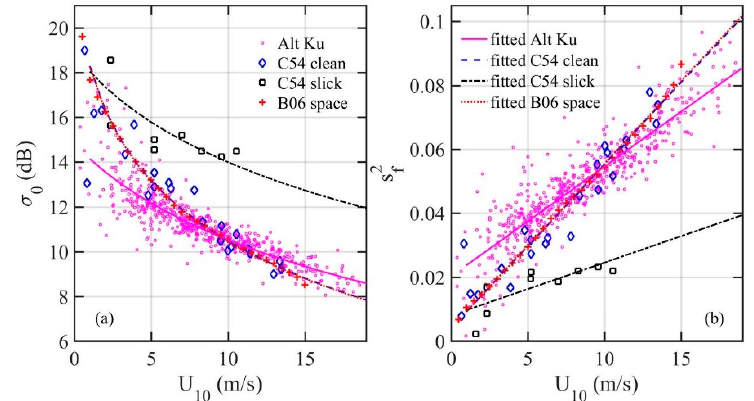
Figure 2. ( a ) Ku band altimeter NRCS and comparison with computational results using Equation (9) with the optical MSS in clean and slick waters: C54 and B06. ( b ) The MSS computed using Equation (9) with the Ku band altimeter NRCS and comparison with the optical MSS in clean and slick waters. The smooth curves are linear fitting to the three sets of MSS data. The smooth curves in ( a ) are the NRCS computation using Equation (9) with the linear fitted curves of the MSS data.